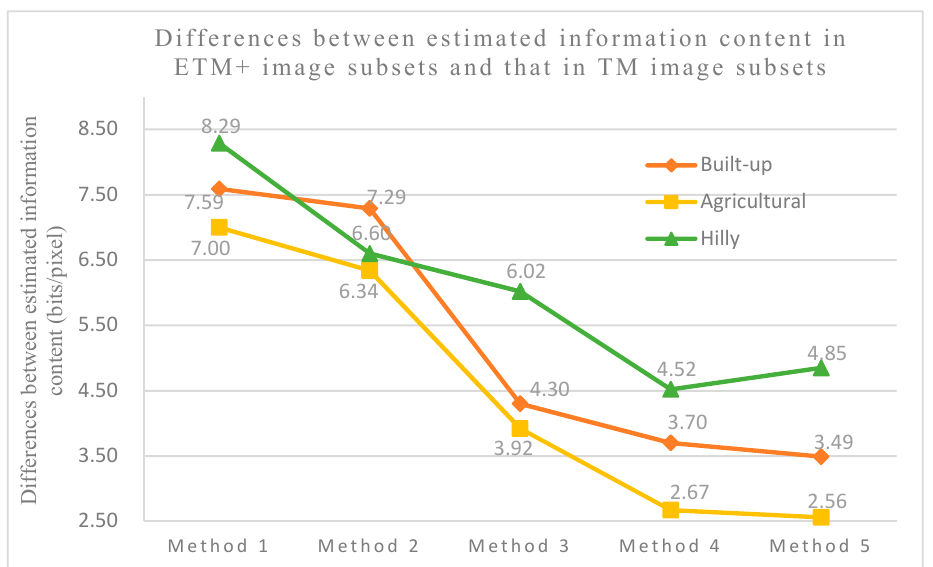
Figure 6. Di ff erences in information content between Landsat ETM + and Landsat TM image subsets, Figure 6. Differences in information content between Landsat ETM+ and Landsat TM image subsets, estimated by di ff erent estimated by different methods.